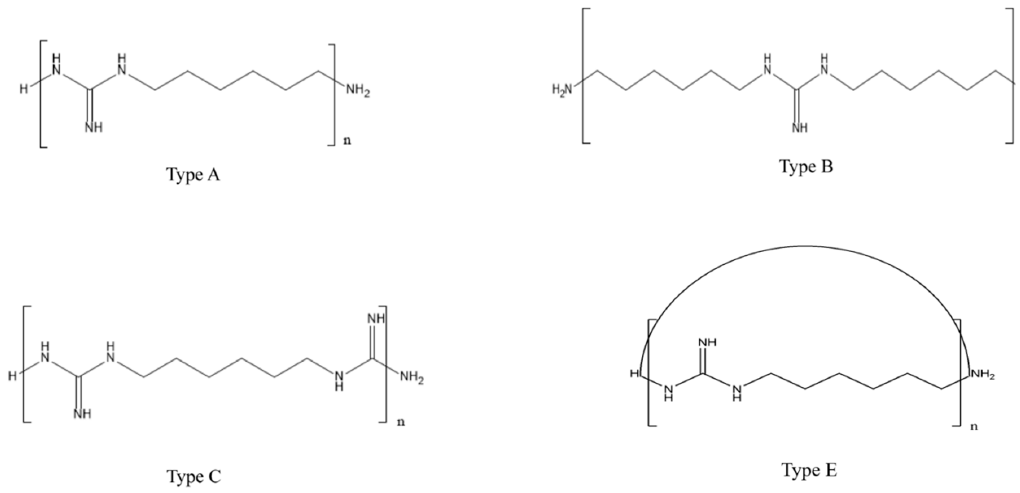
Figure 1. Structures of four isomeric types of PHMG oligomers in HD products, as identified in the MALDI-TOF MS